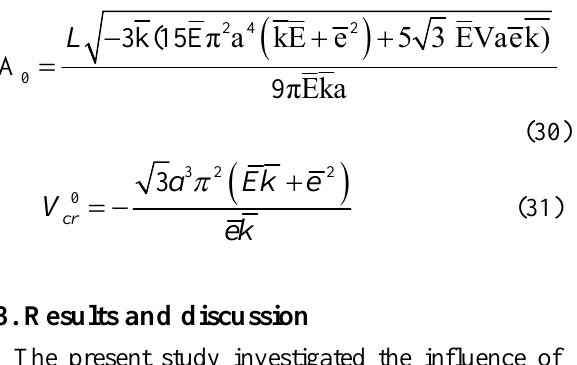
Fig. 2 . The normalized critical voltage with surface elasticity versus the thickness h and side a. To study surface elasticity,